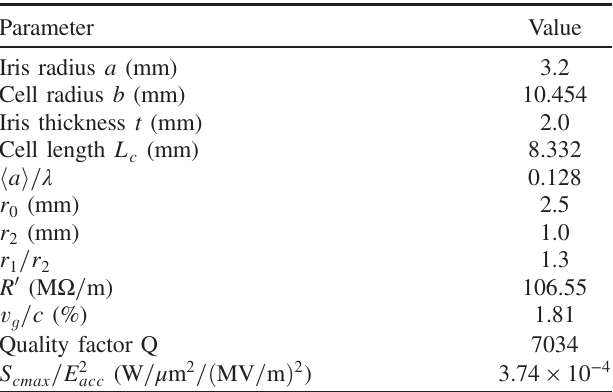
TABLE I. Optimized rf structure parameters for a representa- tive single cell with a ¼ 3 . 2 mm.